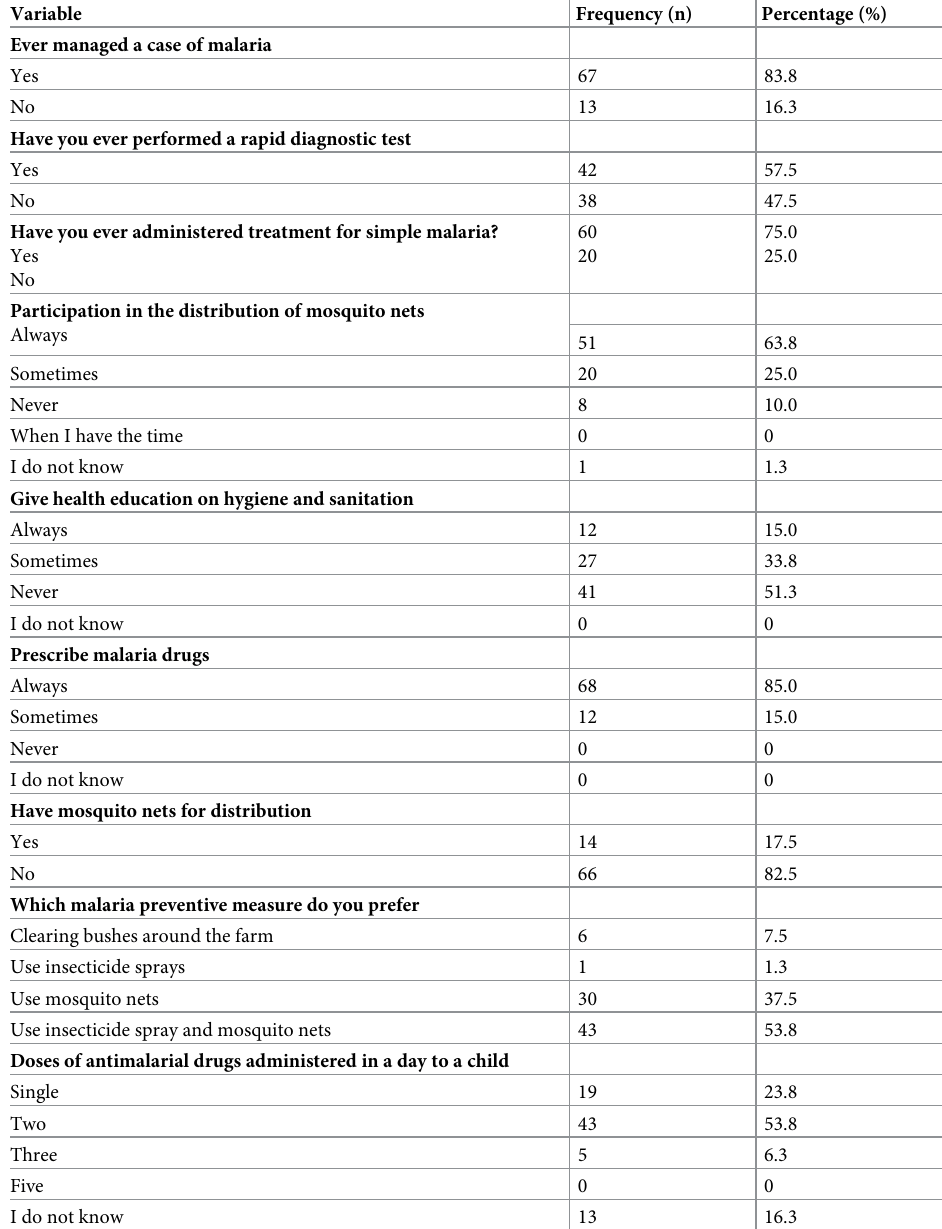
Table 5. CHWs’ practices on management and prevention of childhood